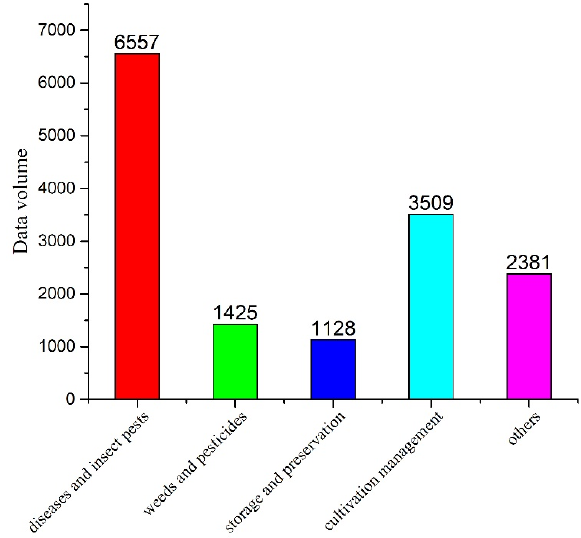
Figure 1. Category distribution of rice question and answer corpus.